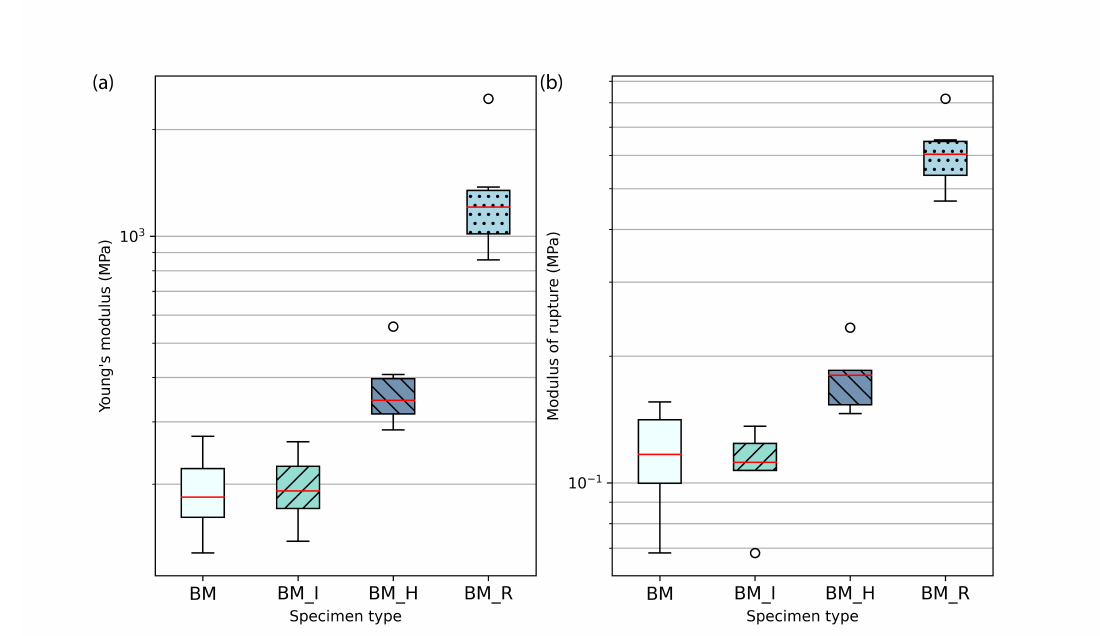
Figure 3. Flexural modulus ( a ) and modulus of rupture ( b ) box plots results.